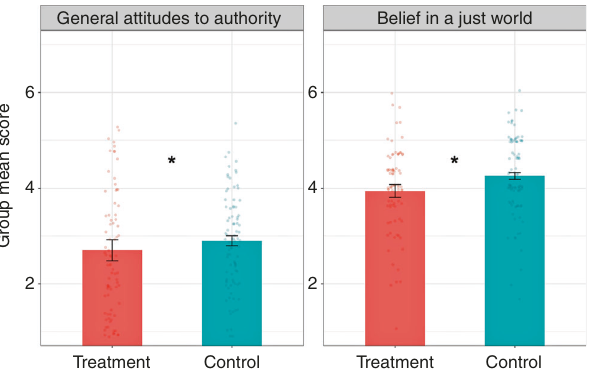
Fig. 2 Study 2 group mean ratings. Study 2 group mean ratings of general attitudes toward authority and belief in a just world on a 7-point scale. Ratings are shown as a function of assignment to participatory meetings condition (treatment). Error bars show 95% con fi dence intervals. Linear regression with fi xed effects included a dummy variable indicating treatment, and a vector of pre-treatment individual demographic covariates to improve ef fi ciency. Robust standard errors clustered by group accounted for residual covariance on the group level. Two-tailed p -values for the average treatment effect on attitudes toward general authority and justice were 0.037 and 0.045 respectively. There was a joint signi fi cance of the average treatment effects on both attitudinal outcomes